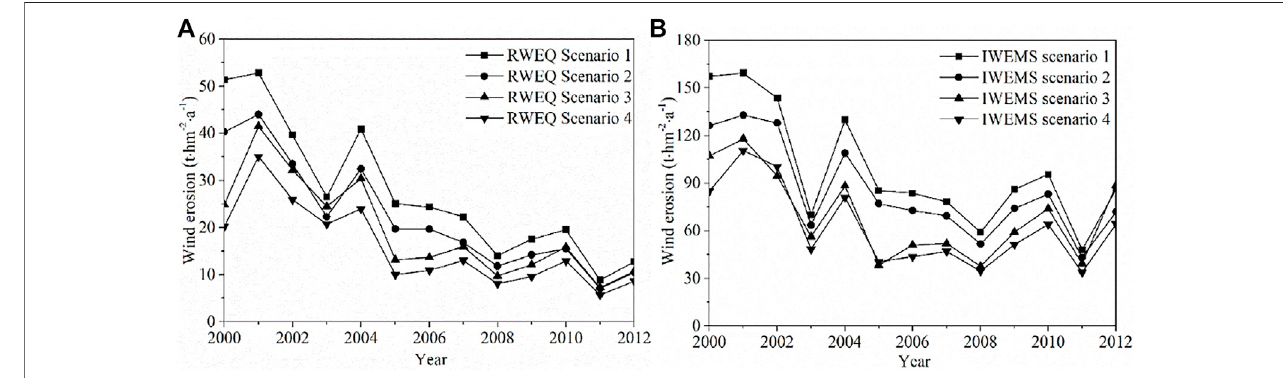
FIGURE 4 | Inter-annual variations in the average potential wind erosion obtained using (A) the RWEQ and (B) IWEMS for the different scenarios.